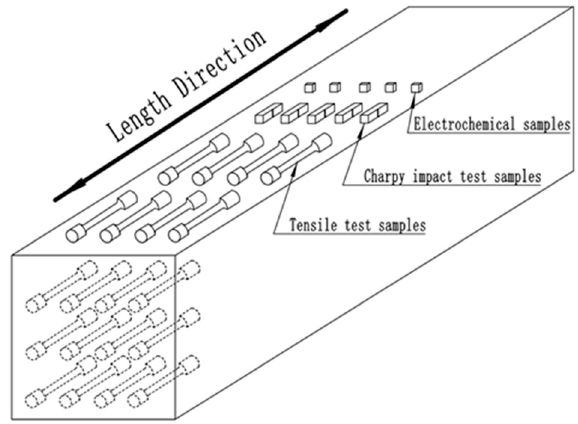
Figure 1. Sampling schematic for test specimens.